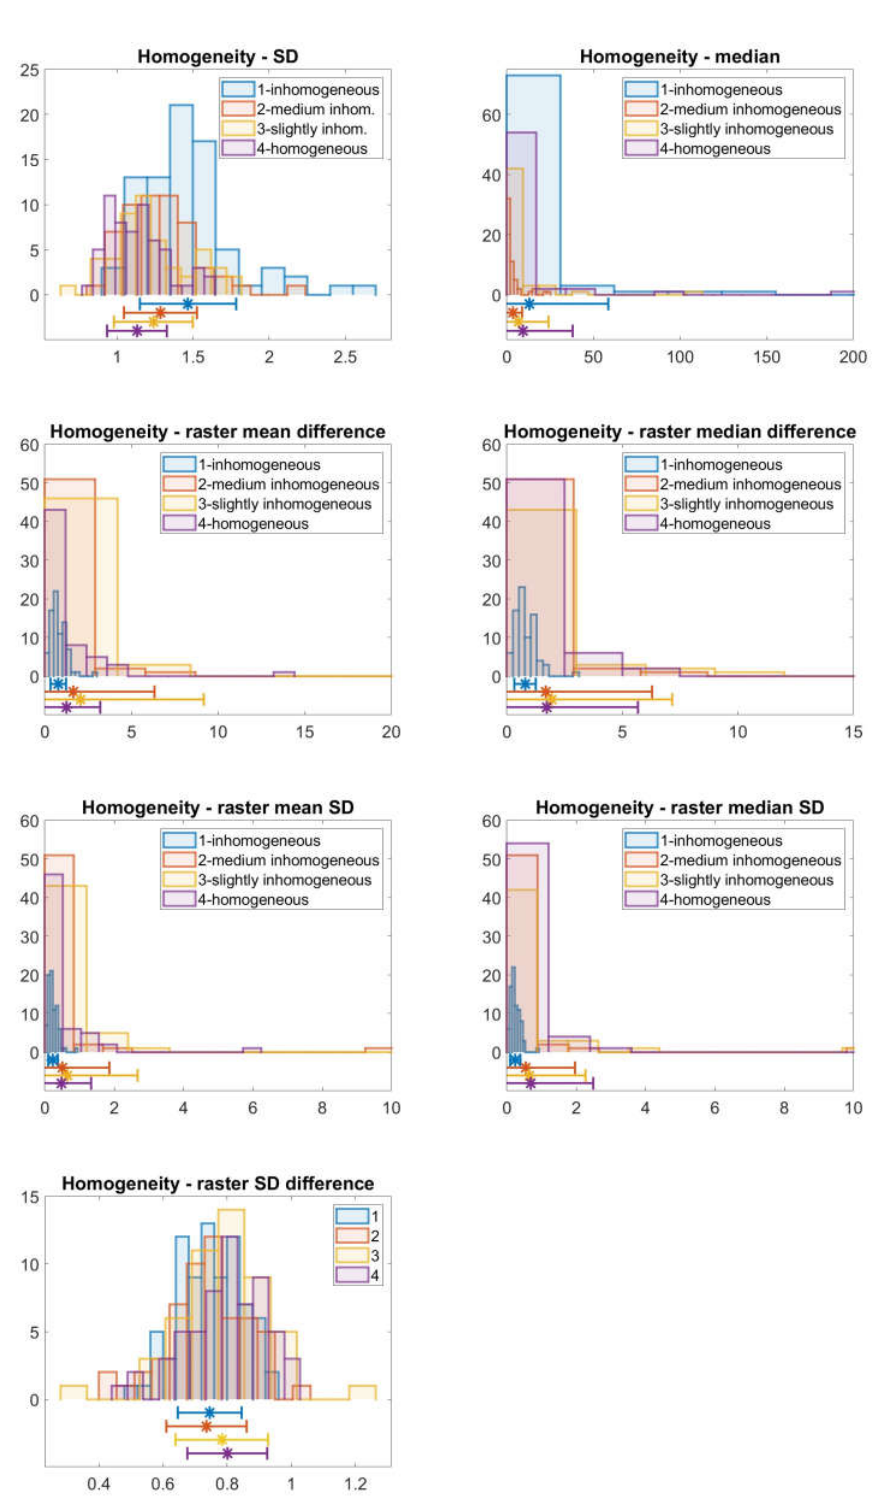
Figure 8. Expert opinion vs. computer calculated homogeneity values (10) to (16). The expert categories are represented as different colors, according to the legend. The upper part of the images shows the histograms of the distribution of the machine calculated quantities for the different experts’ categories, the lower part of the images shows their mean value by a marker *, and their standard deviation as the interval around the mean value. The same color is used for the histograms, mean, and standard deviation (the distance of the intervals from the horizontal axis is only for distinguishing them, it has no